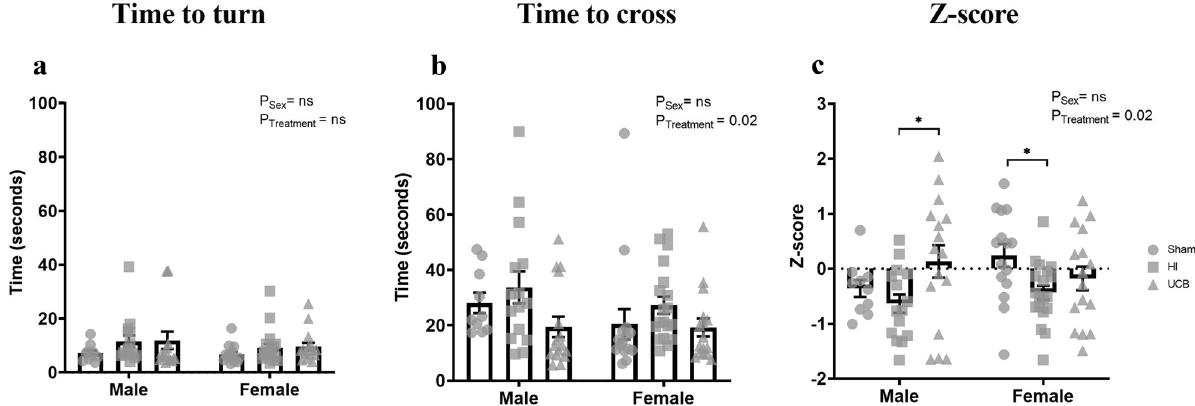
Figure 1. Raw and transformed scores for negative geotaxis analysis. The time taken to turn 180° on the angled board ( a ) and walk up the angled board ( b ) on PND14. Raw scores were transformed into a negative geotaxis Z-score ( c ). A positive Z-score reflects an improvement in behaviour, negative Z-score reflects deficit in behaviour. (In these graphs, the sham group is represented by a circle, the HI group is represented by a square and the UCB groups is represented by a triangle. Data expressed as mean ± SEM, n = 10–19 pups per group, *P <